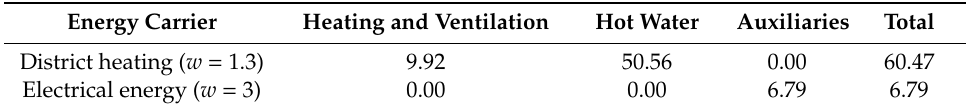
Table 18. The annual EK demand (kWh / (m 2 · year)) for the multi-family building at Akacjowa Street in